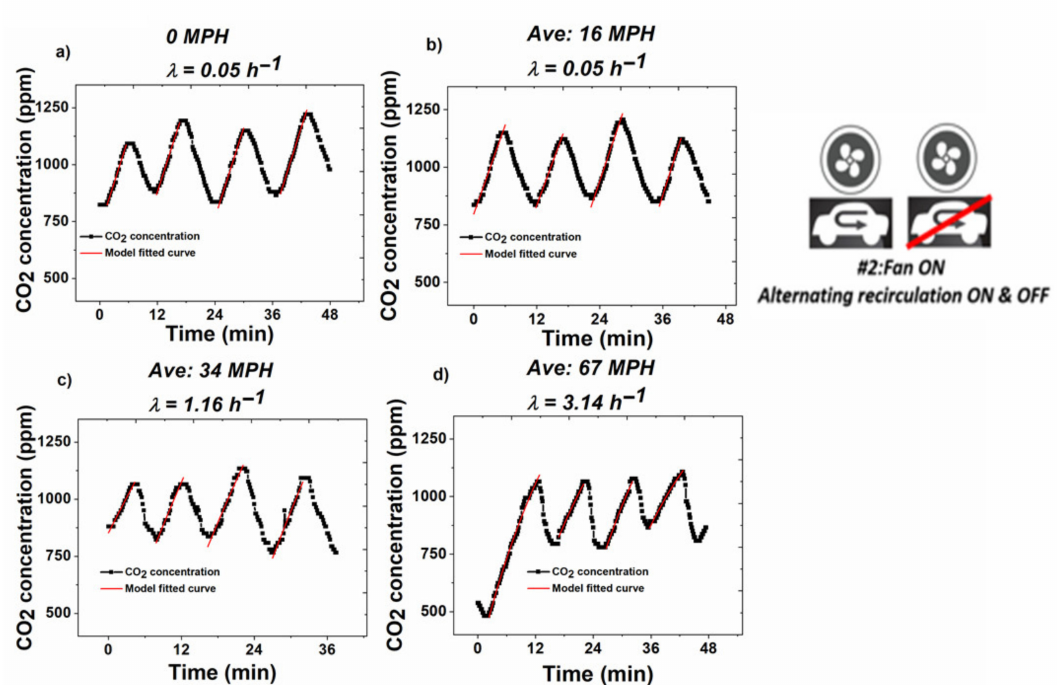
Figure 4. Real-time CO 2 concentration profile and the model fitted curve (red) under di ff erent driving speed. ( a ) 0 MPH; ( b ) 16 MPH; ( c ) 37 MPH; ( d ) 64